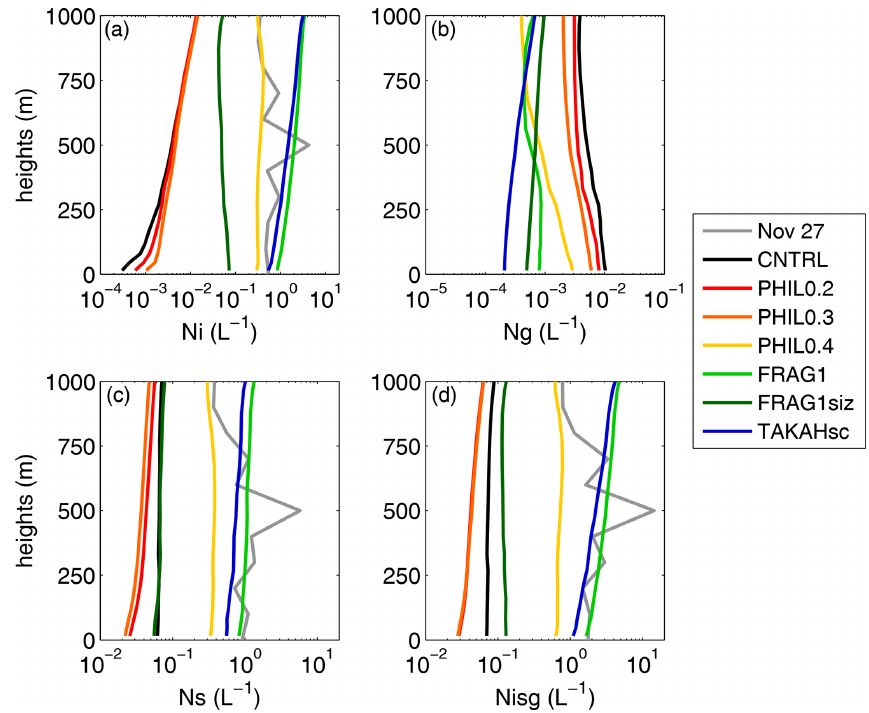
Figure 3. Mean vertical profiles of number concentrations of modeled (a) cloud ice, (b) graupel, (c) snow and (d) total ICNCs for seven sim- ulations. Gray lines represent measured concentrations with diameters (a) smaller and (c) larger than 250µm. Graupel concentrations cannot be distinguished in the measurements (hence no gray profile in panel b ). Ice properties from the model are calculated for N isg > 0 . 005L − 1 . For consistency with observations, only particles with sizes > 80µm are included in the modeled profiles in panels (a) , (c) and (d)